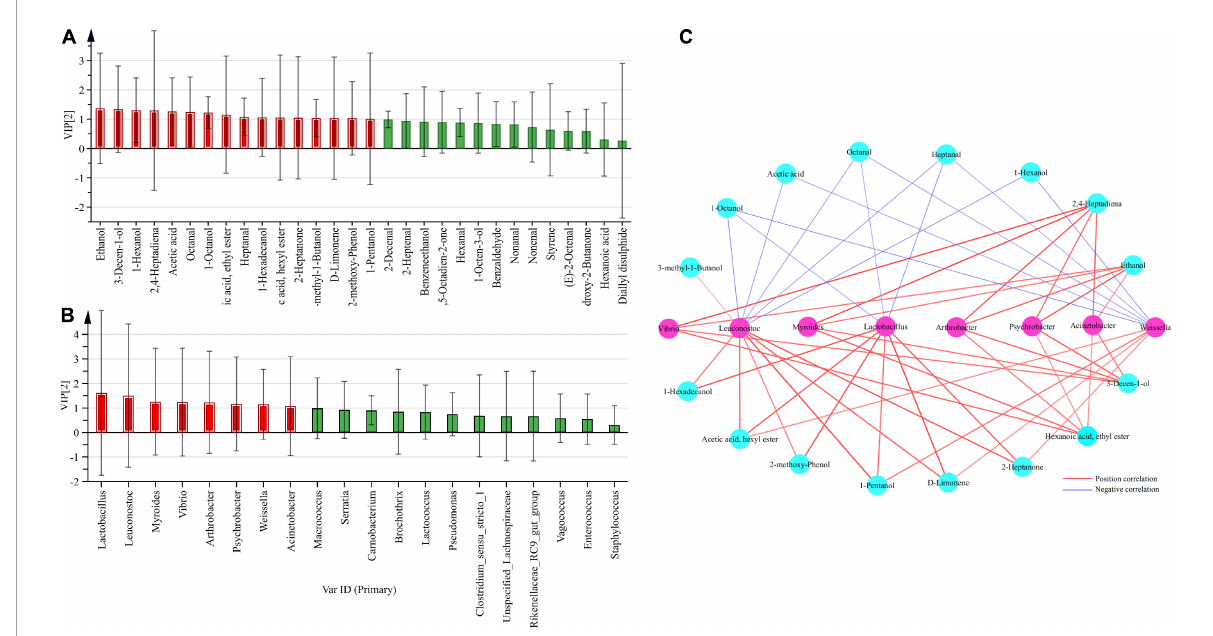
FIGURE6 Analysis of the core microbes and volatile compounds by O2PLS modeling. (A) VIP (variable importance for predictive components) plot of bacteria vs. the top 30 volatile compounds. (B) VIP plot of volatile compounds vs. the top 20 bacteria. (C) Correlation analyses of core bacteria and volatile